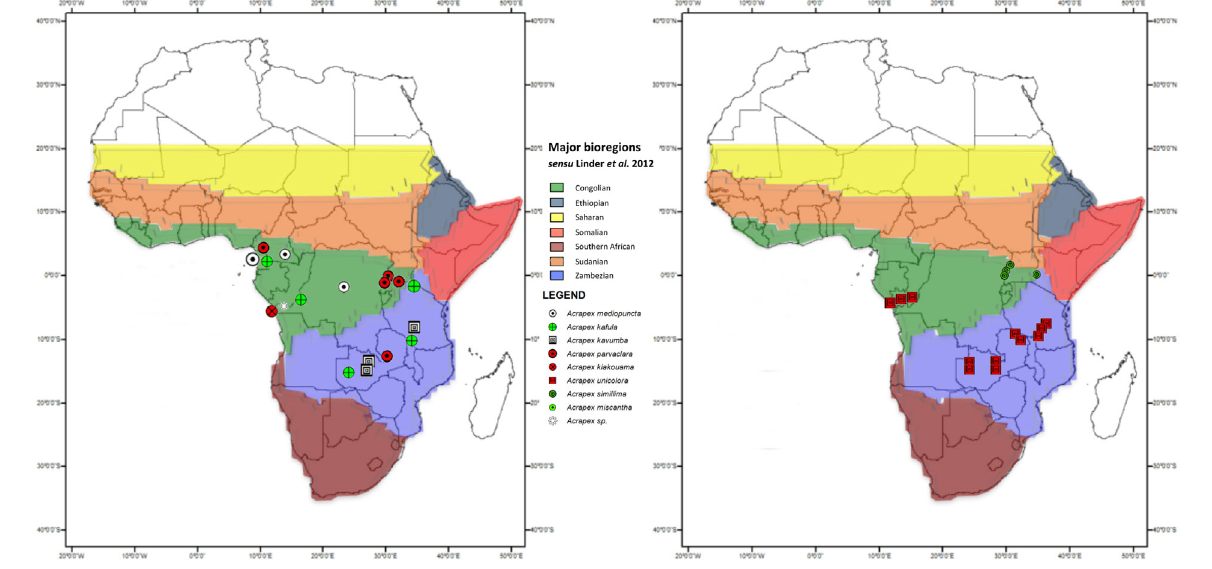
Fig. 5. Major bioregions, modified after Linder et al.